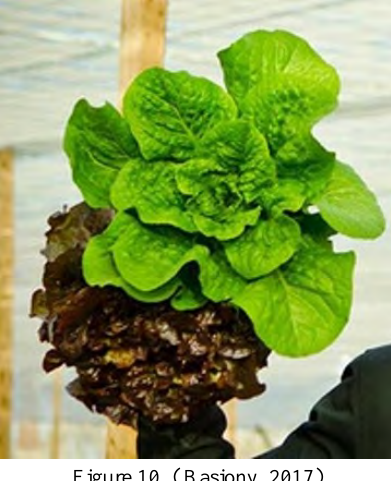
Figure 10. ( Basiony,